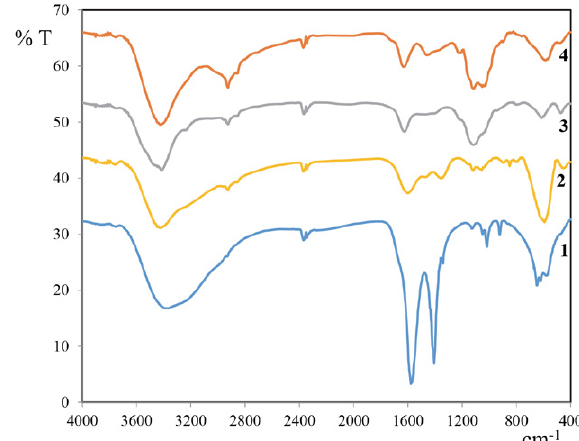
Tabari et al.: Magnetic Nanoparticles Linked ...